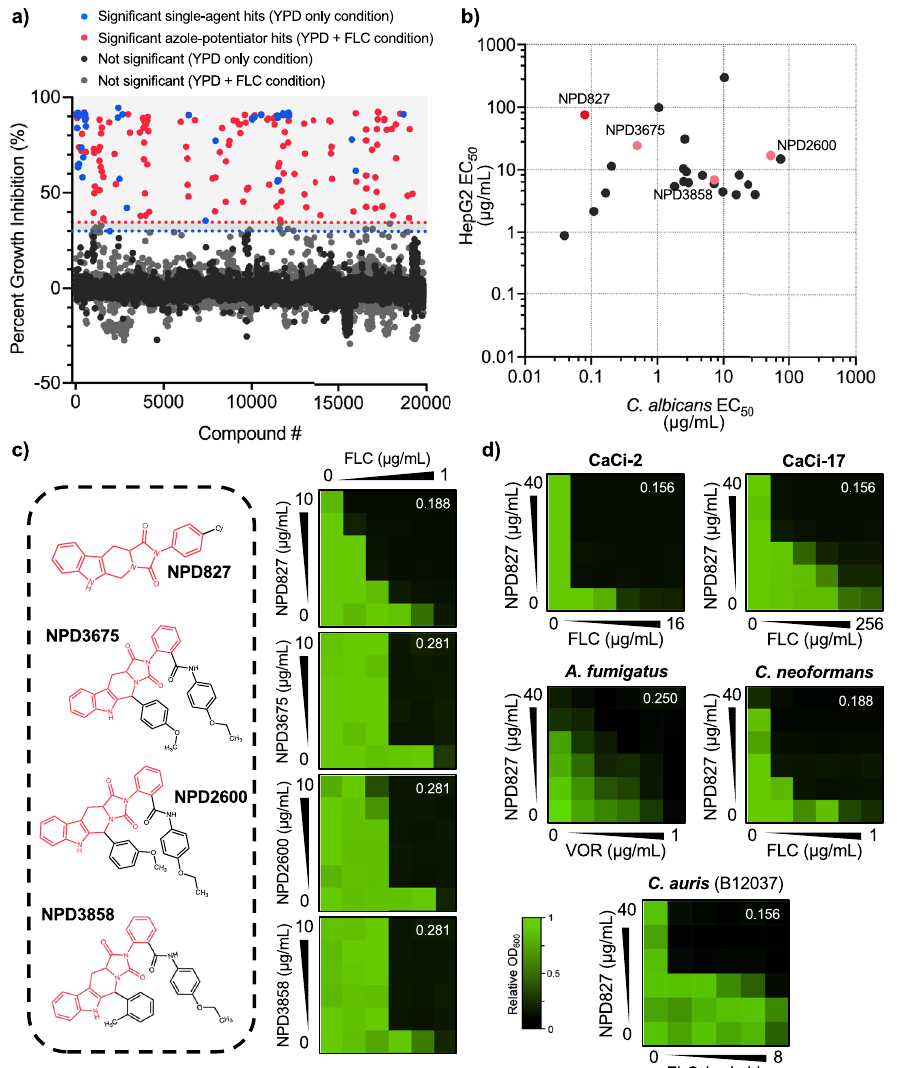
Fig. 1 RIKEN Natural Product Depository screen against C. albicans identi fi es compounds that potentiate azole activity. a Screening data are reported as percent growth inhibition (%) in the absence and presence of fl uconazole (FLC, 1 μ g/mL). Compounds are colored based on classi fi cation as single agent-active (blue, ≥ 20-MAD above median growth inhibition), or azole potentiator (red, ≥ 20-MAD above median growth inhibition with fl uconazole). b Fungal versus human growth inhibition for the top 24 compounds identi fi ed in the primary screen. EC 50 values were calculated by nonlinear regression curve fi tting of triplicate determinations from dose – response assays against human cells (HepG2) and C. albicans (CaSS1). All assays were performed in the presence of 0.25 µ g/mL of FLC. Pink data points indicate compounds belonging to the imidazopyrazoindole class. Red data point highlights NPD827. c Checkerboard assays with four imidazopyrazoindoles in combination with FLC. Checkerboards were performed in YPD medium at 30 °C against C. albicans (CaSS1) and growth was measured using absorbance at 600 nm after 24 h. Technical duplicates were averaged, and measurements were normalized to no drug controls. Relative growth is quantitatively represented by color (see scale bar at bottom). Compound structures are depicted on the left and checkerboard heatmaps are depicted on the right. Fractional Inhibitory Concentration Index (FICI) values are displayed in the top right corner of each checkerboard (FICI < 0.5, synergistic interaction). d Checkerboard assays were performed with NPD827 and either fl uconazole (FLC) or